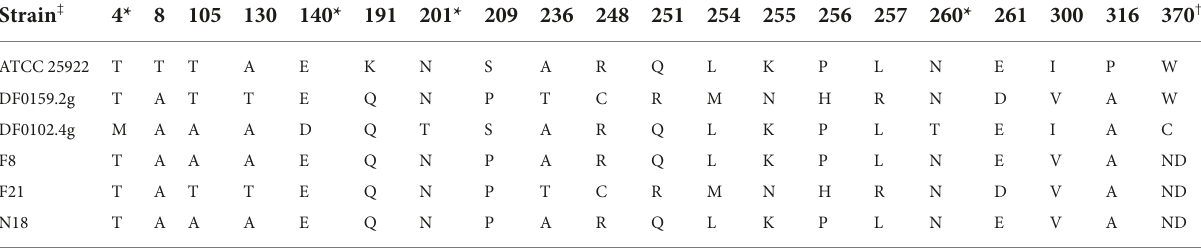
TABLE 2 Amino acid substitution profiles of suspected extended-spectrum AmpC β -lactamase producing E. coli from this study. Strain ‡